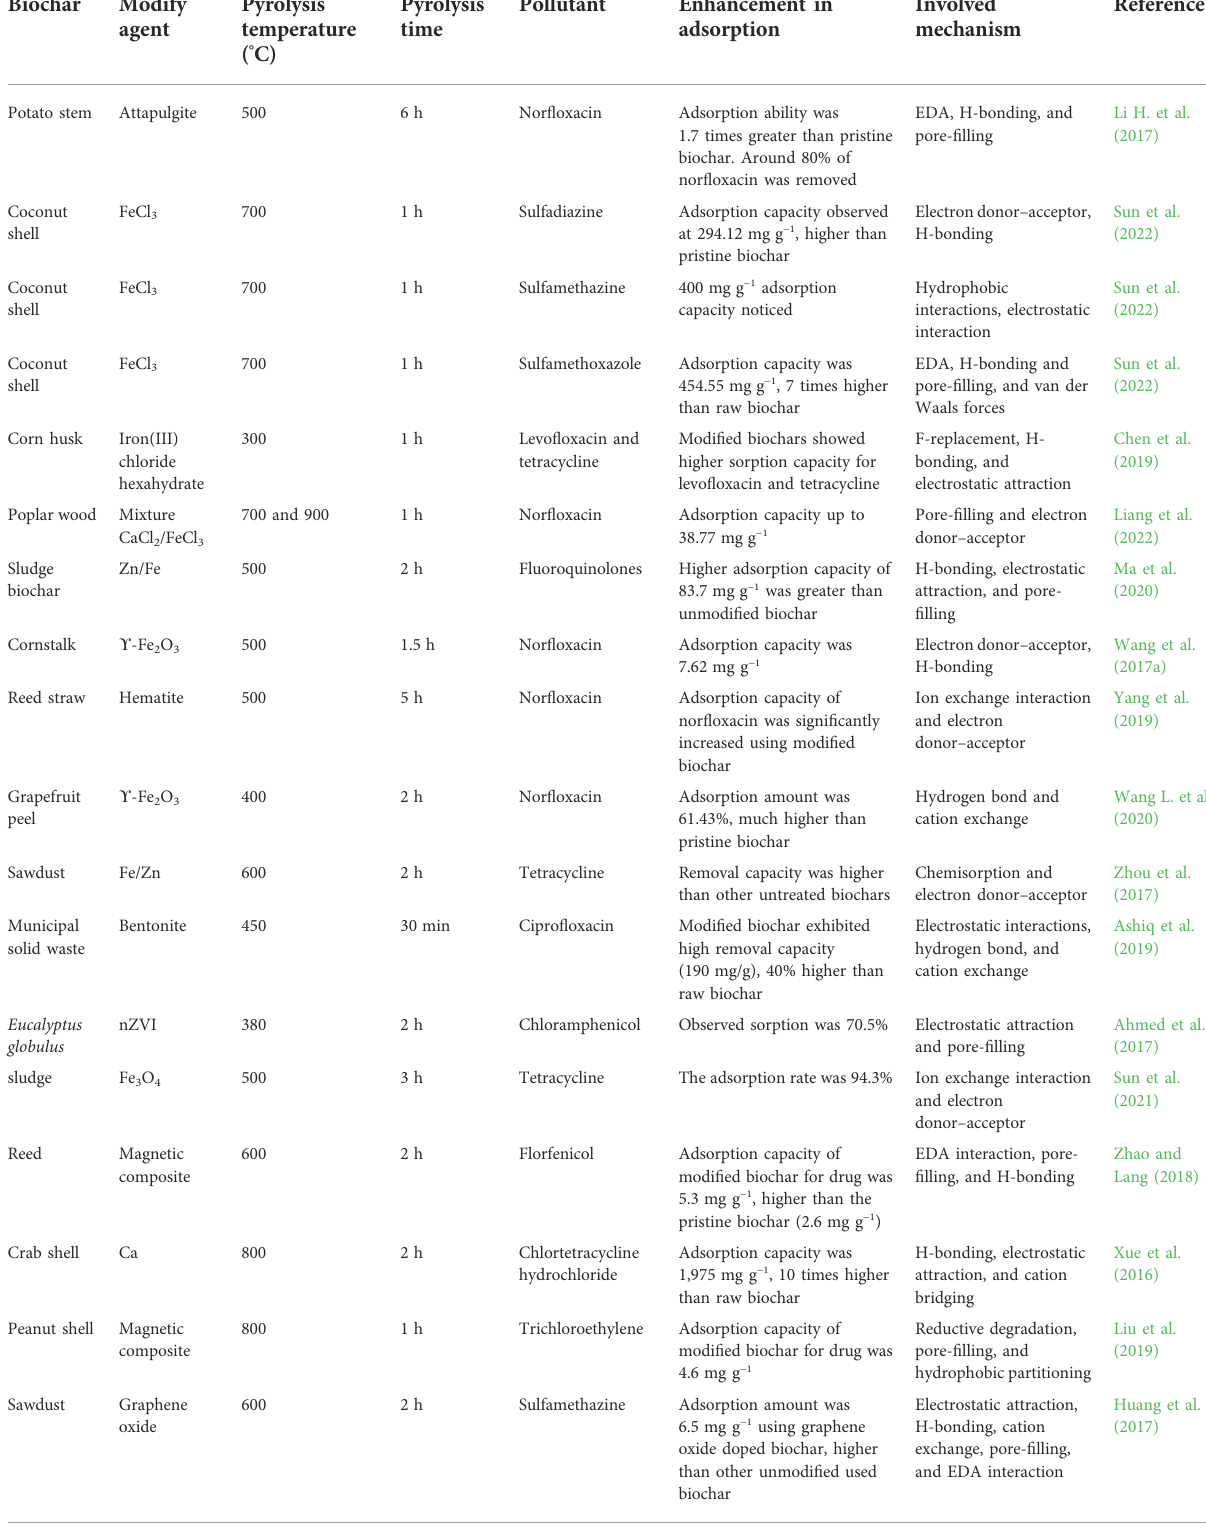
TABLE 4 Modi fi ed/engineered biochar used to remove antibiotics from the